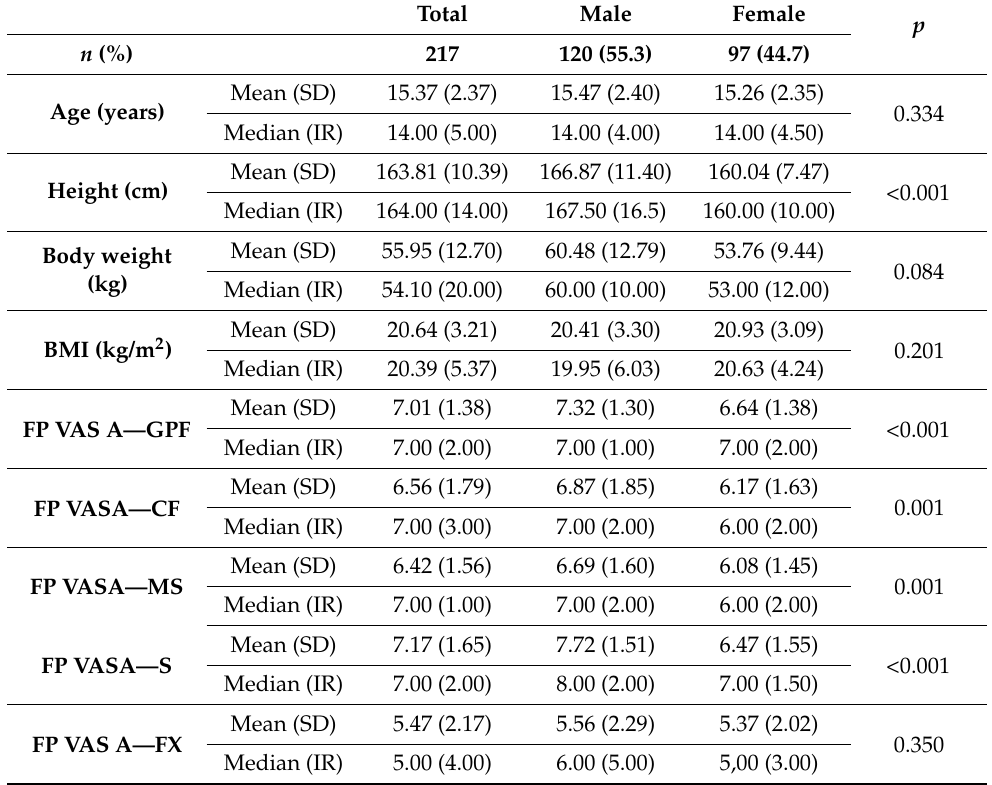
Table 3. Participants’ anthropometry and FP VAS values.